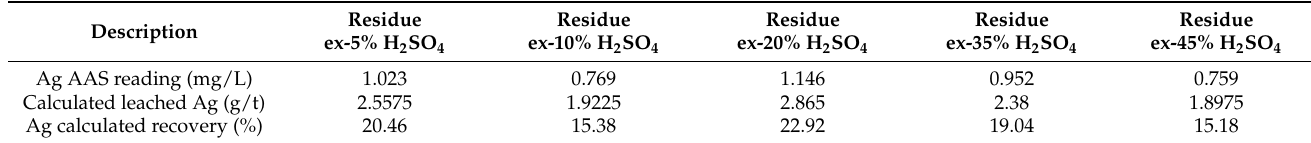
Table 11. Cyanidation stage: results of Ag in solution.